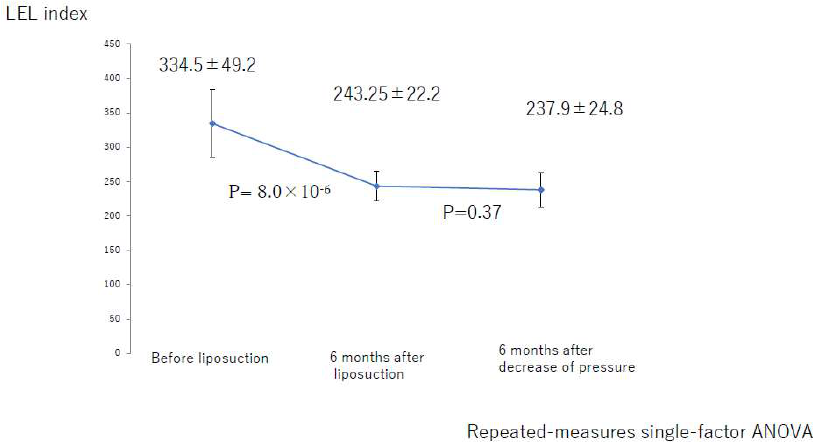
Figure 14. Changes in the LEL index over time in the group with successful liposuction. ANOVA, analysis of variance; LEL, lower extremity lymphedema.